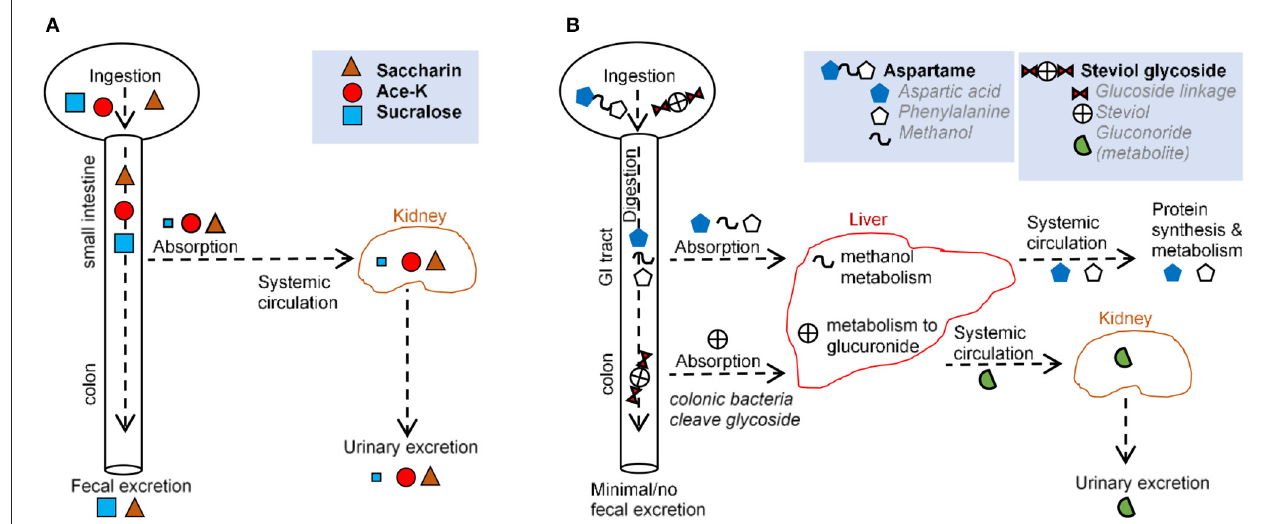
FIGURE 2 | Comparison of main routes of absorption, digestion, metabolism, and excretion of representative AS (A,B) illustrate the absorption, digestion, metabolism, and excretion for (A) saccharin, acesulfame-potassium, sucralose, and (B) aspartame and steviol glycoside.